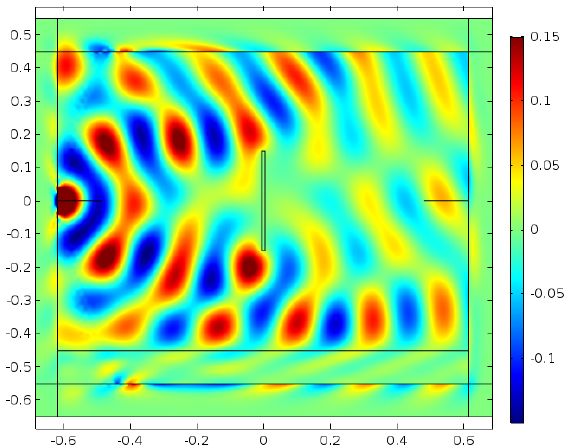
Figure 13. The simulated z component of the electric field ( E z ) at 1.55 GHz, when the configuration is MET. One can observe the difference between the superior and inferior halves of the open-space domain, due to the reflection on the floor. In this simulation, − 0.37 ≤ E z ≤ 0.40 V/m. For better contrast, the color range was set to ± 0.15. The in-plane coordinates x (horizontal) and y (vertical) are in